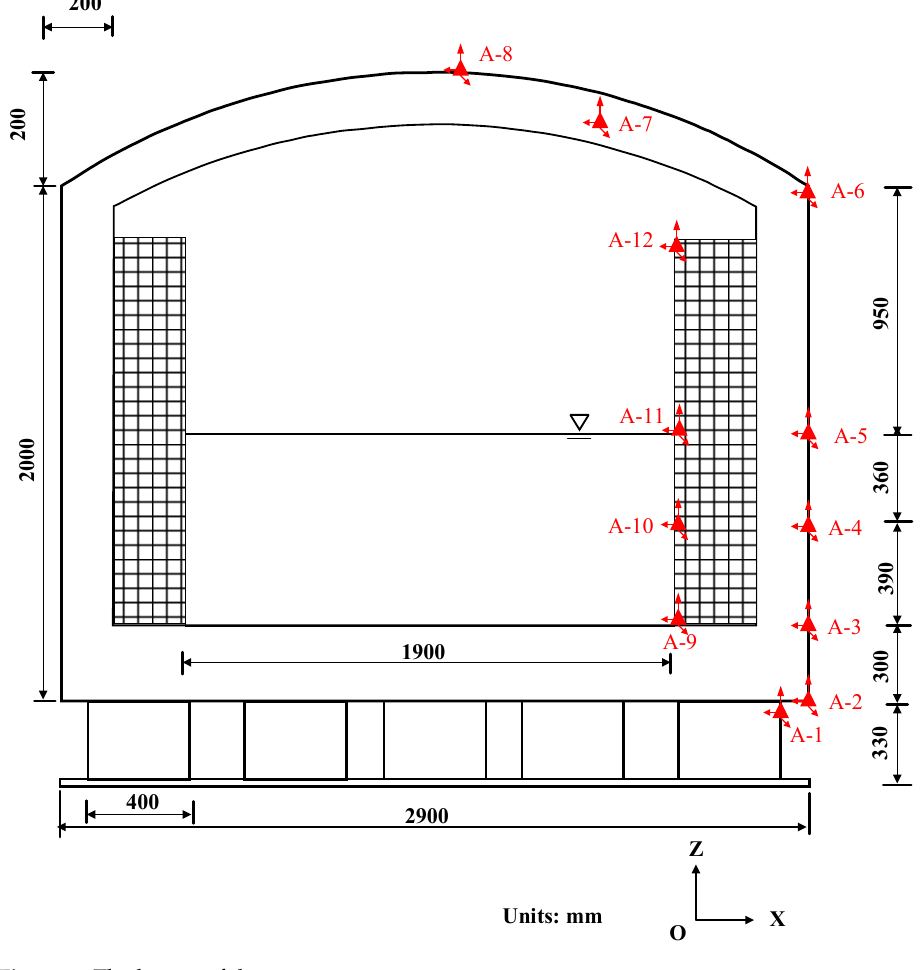
Figure 5. The layout of the sensors. Table 1. Statistical indicators for the three acceleration